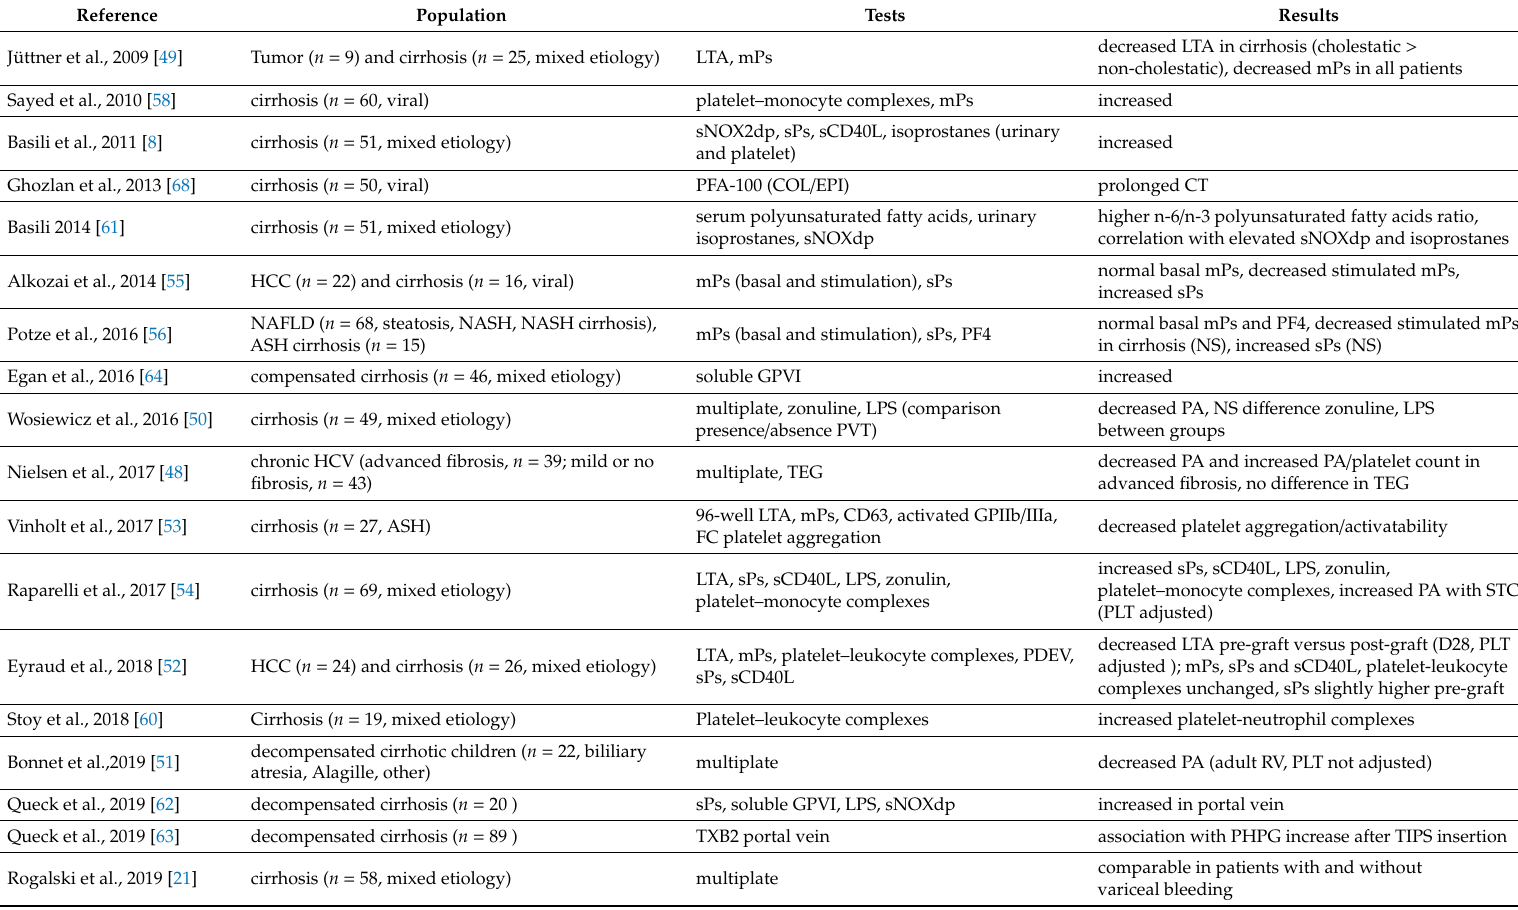
Table 1. Published studies of platelet function in CLD patients over the past